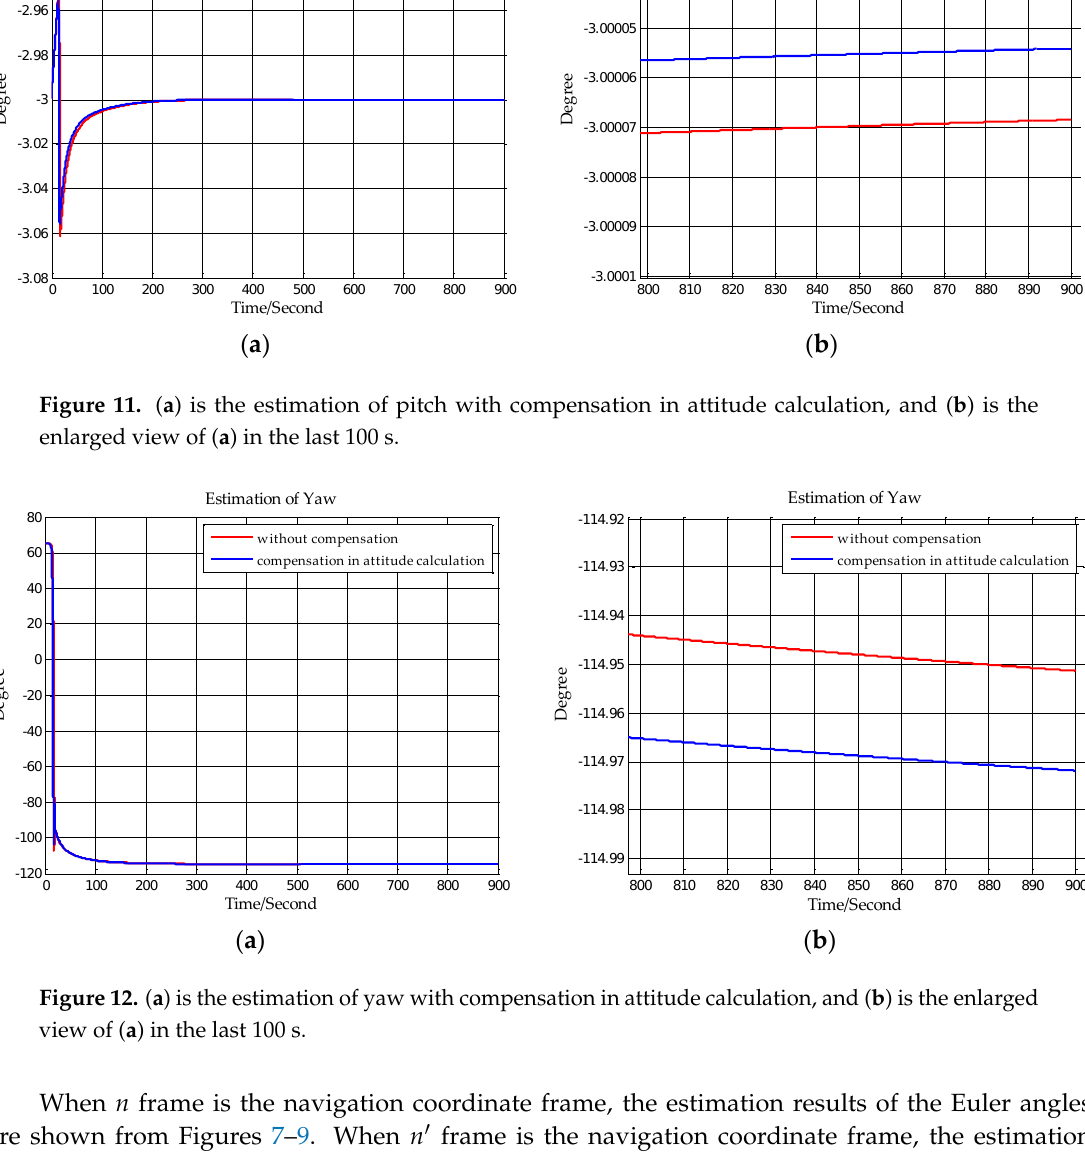
Figure 10. ( a ) is the estimation of roll with compensation in attitude calculation, and ( b ) is the enlarged view of ( a ) in the last 100 s.